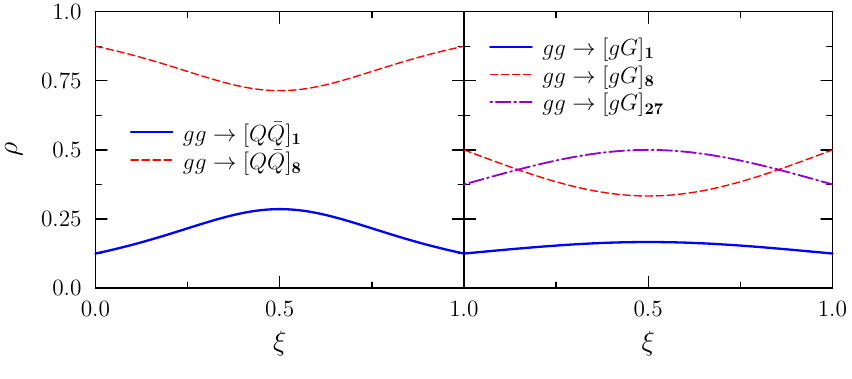
Figure 4 . Probabilities ρ ( ξ ) for the produced dijet to be in colour state R, as a function of the R internal energy fraction ξ , in the gg → Q ¯ Q channel for R = 1 , 8 (left) and in the gg → gG channel for R = 1 , 8 ≡ 8 a ⊕ 8 s , 27